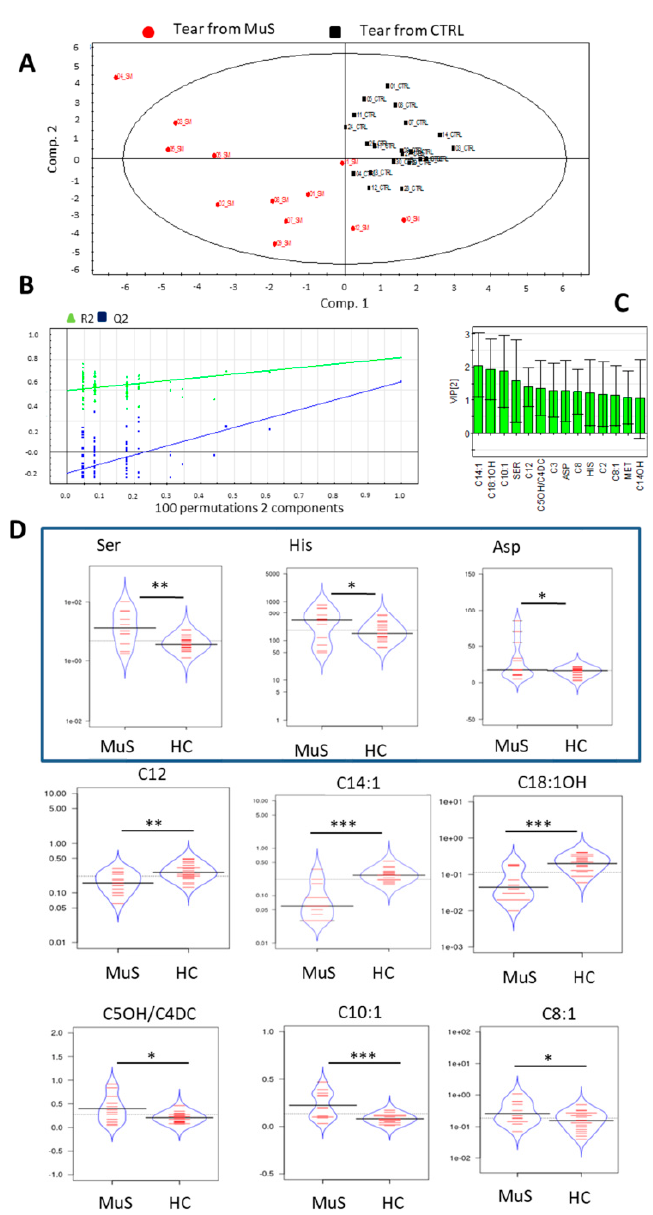
Figure 4. Tears metabolomics investigation by PLS-DA ( A ) Panel shows the Scores scatter plot calculated on two components using 43 tear metabolite concentrations. The PLS-DA) are used to classify tears from MuS patients (symbolized as red dots) from HC (indicated as black squares) obtained by R2Y = 0.77 and Q2(cum) = 0.586. ( B ) Panel shows the validate model plots for tears PLS-. The plot shows on the vertical axis the R2 and Q2 for the original model (far to the right) and of the Y-permutated models further to the left. ( C ) Panel shows the VIP plots related to the PLS-DA of tear metabolomics investigation. ( D ) We report the distribution of the significantly different AAs and ACs in the two analyzed groups, visualized as the bean plots. In these plots the polygon shape (in blue line) represents the density trace computed using a log-transformation of each variable, and next to that, a scatter plot shows all individual measurements (red line). * means p < 0.05, ** means p < 0.01 and *** means p < 0.001 at the Student’s t